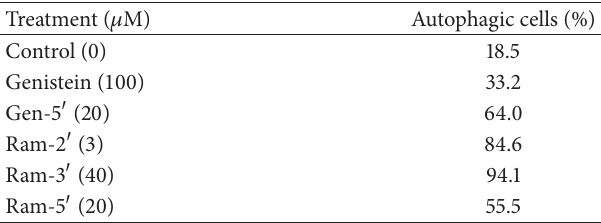
Table 4: The percentage number of autophagic cells in PC3 cell line. Treatment ( 𝜇